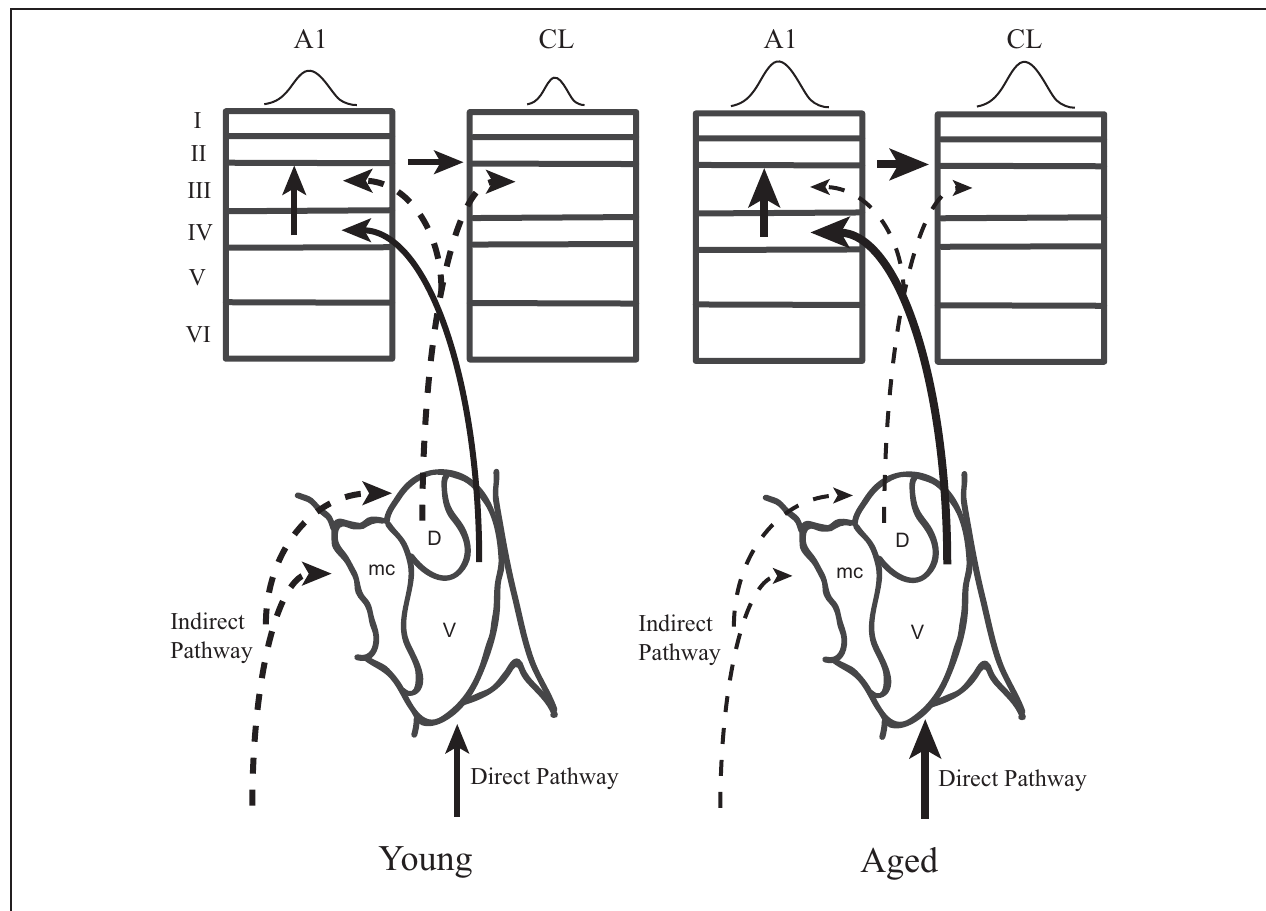
projects to the upper layers of both A1 and CL. A1 also projects directly to CL. Requiring coincidence of these two pathways is one mechanism by which spatial tuning could be sharpened in CL relative to A1 in young monkeys. In aged monkeys, the increase of activity in A1 and CL degrades with the cortical dynamics that sharpen spatial tuning in CL relative to A1. Abbrevations: V, ventral division of the MGN; D, dorsal division of the MGN; mc, medial division of the MGN; A1, primary auditory area; CL, caudolateral belt